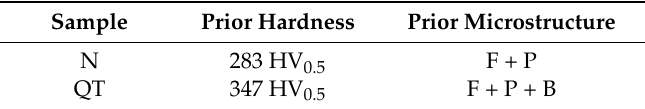
Table 7. Prior surface hardness of N and QT